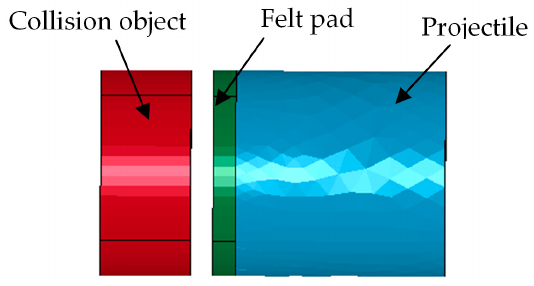
Figure 7. Finite element model of the collision process.